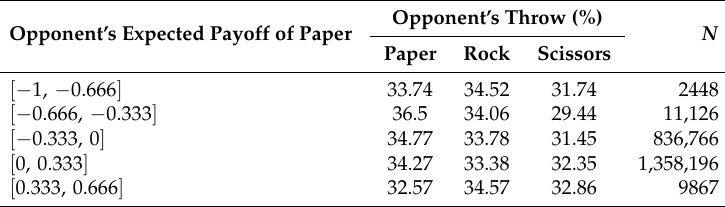
Table A6. Opponents’ Response to Expected Payoff of Paper.